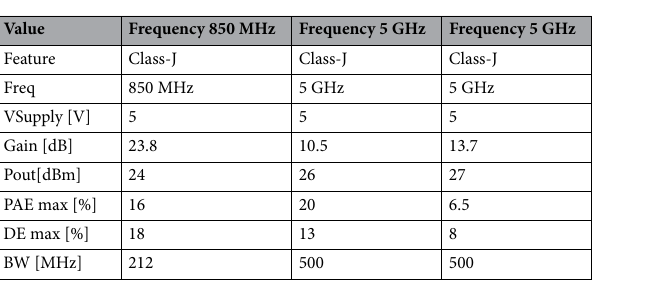
Table 1. Performance comparison of designed Class-J PA.